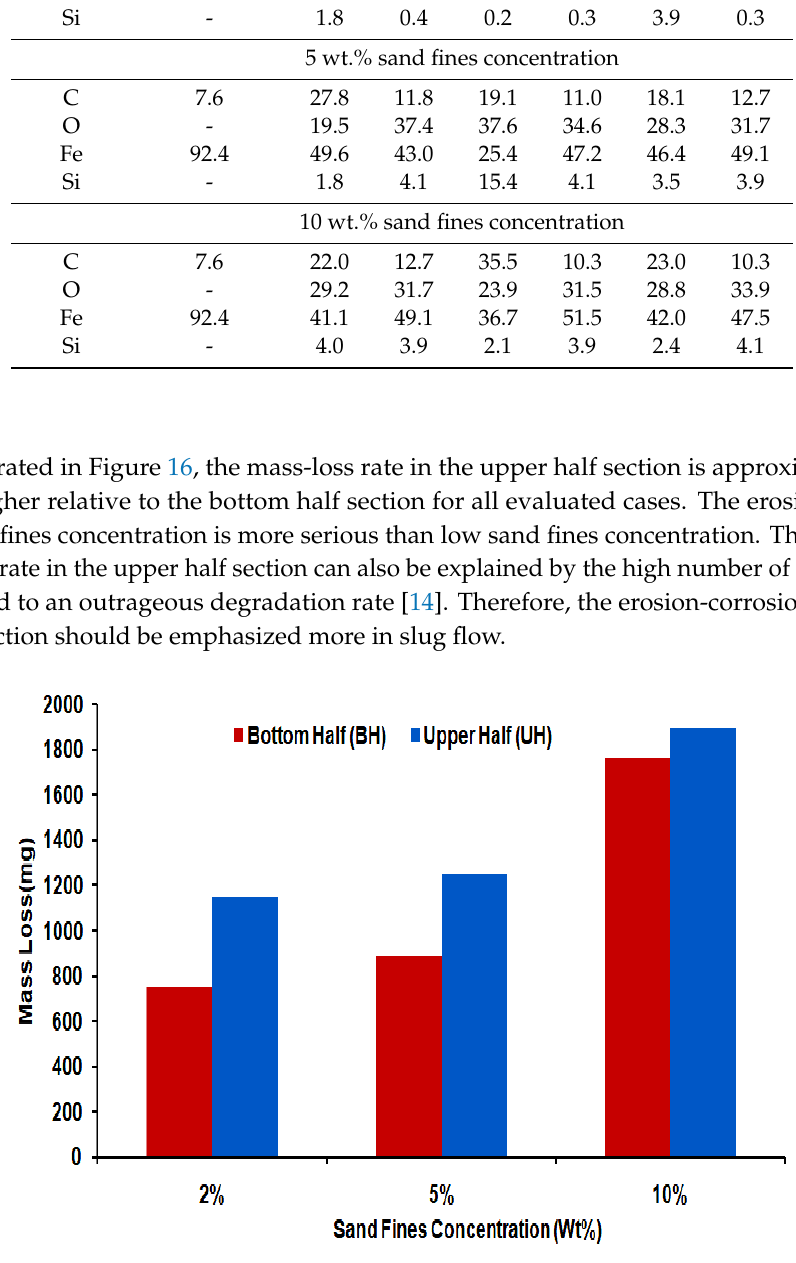
Figure 16. Mass loss in 1018 CS bottom half and upper half elbows section after exposure of slug flow with different sand fines concentration for 10 h.